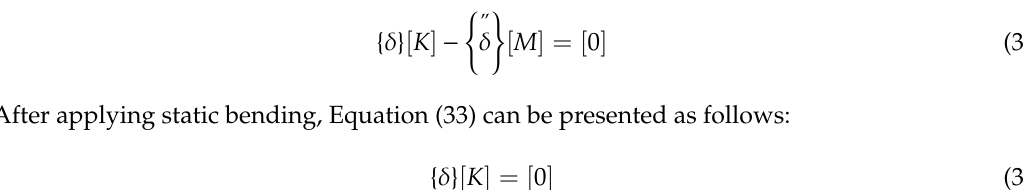
Table 5. Validation of numerical results with finite element outcomes (b/a = 5, h = a/10, R 1 = 6a, R 2 = 2a, ∆𝑇 (cid:3404) 20𝐾, 𝑔 (cid:3008)(cid:3017)(cid:3013) = 1%, and N L = 5).